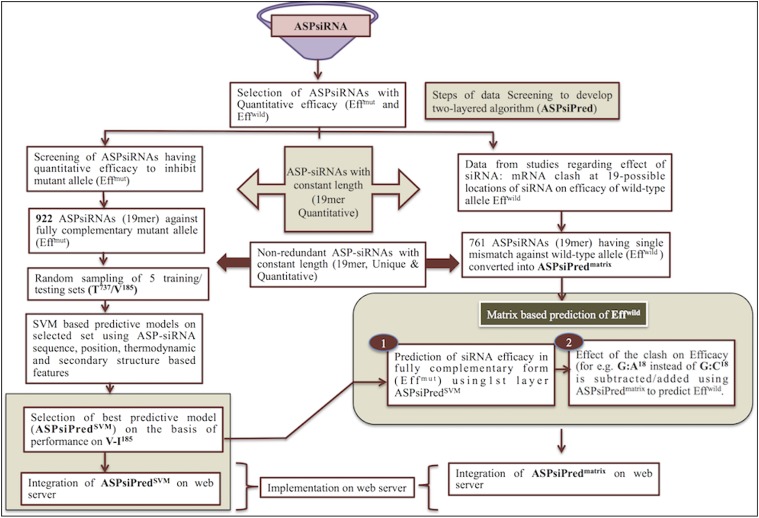
Computational workflow employed to extract ASP-siRNAs and developing the algorithm for the prediction of inhibitory efficacy: left arm describes the development of the SVM-based algorithm (ASPsiPredSVM) for prediction of efficacy for fully complementary mutant allele (Effmut), while the right arm depicts the process of making ASPsiPredmatrix for the prediction of the efficacy for wild-type allele having one mismatch (Effwild).